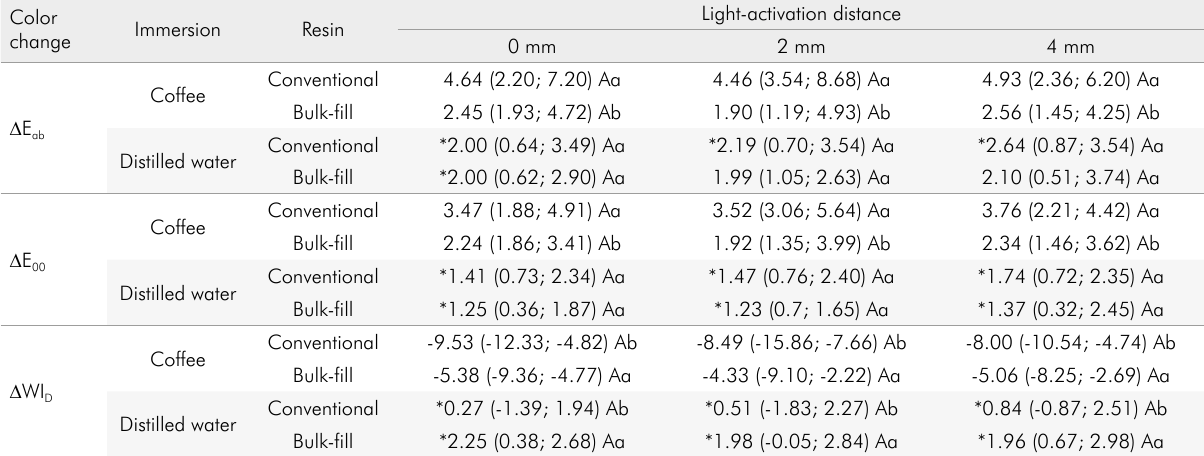
Table 5. Median (minimum value; maximum value) color change ( Δ E composite resin, immersion medium, and light-activation distance.